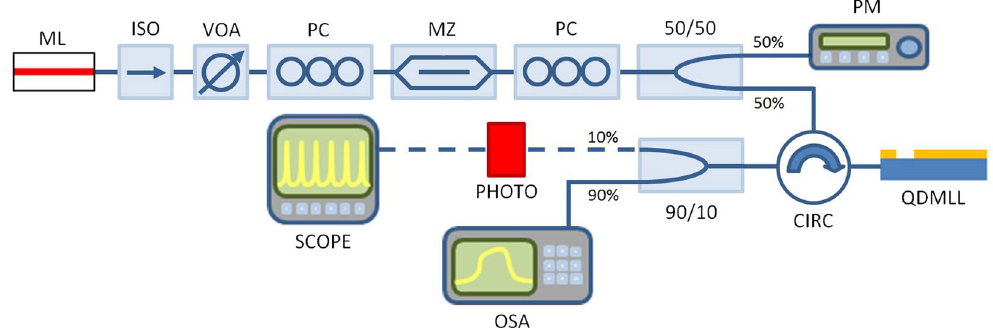
Figure 1. Block diagram of the experimental setup. ML – Master Laser, ISO – Optical Isolator, PC – Polarization Controller, MZ – Mack-Zehnder Modulator, VOA – Variable Optical Attenuator, PM – Power Meter, CIRC – Optical Circulator, QDMLL – Quantum-dot mode-locked laser, PHOTO – Photodiode, OSA – Optical Spectrum Analyser, SCOPE –